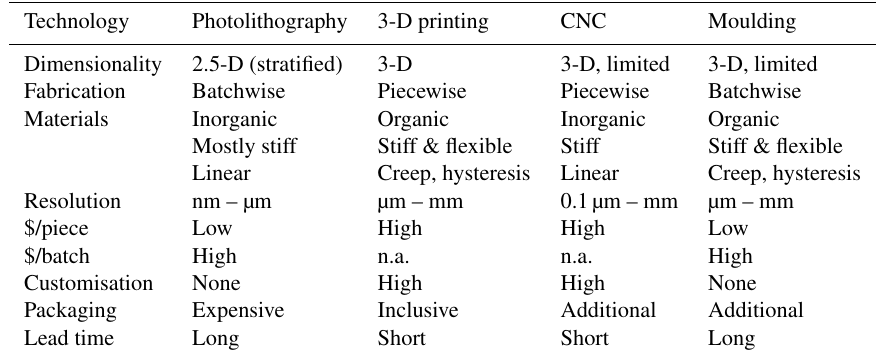
Table 1. Some key features of various fabrication technologies n.a. stands for “not applicable”. Technology Photolithography 3-D printing CNC Moulding Dimensionality 2.5-D (stratified) 3-D 3-D, limited 3-D, limited Fabrication Batchwise Piecewise Piecewise Batchwise Materials Inorganic Organic Inorganic Organic Mostly stiff Stiff & flexible Stiff Stiff & flexible Linear Creep, hysteresis Linear Creep, hysteresis Resolution nm – µm µm – mm 0.1µm – mm µm – mm $/piece Low High High Low $/batch High n.a. n.a. High Customisation None High High None Packaging Expensive Inclusive Additional Additional Lead time Long Short Short